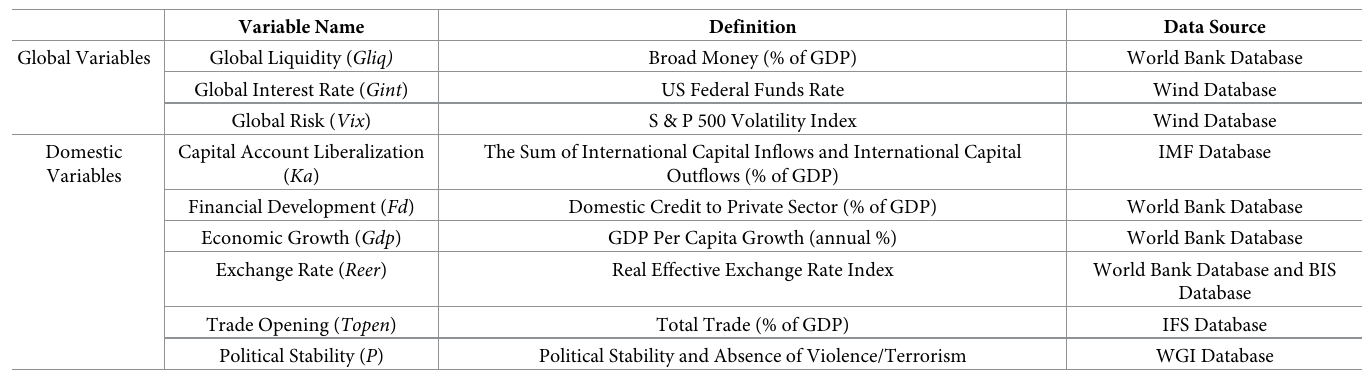
Table 1. Control